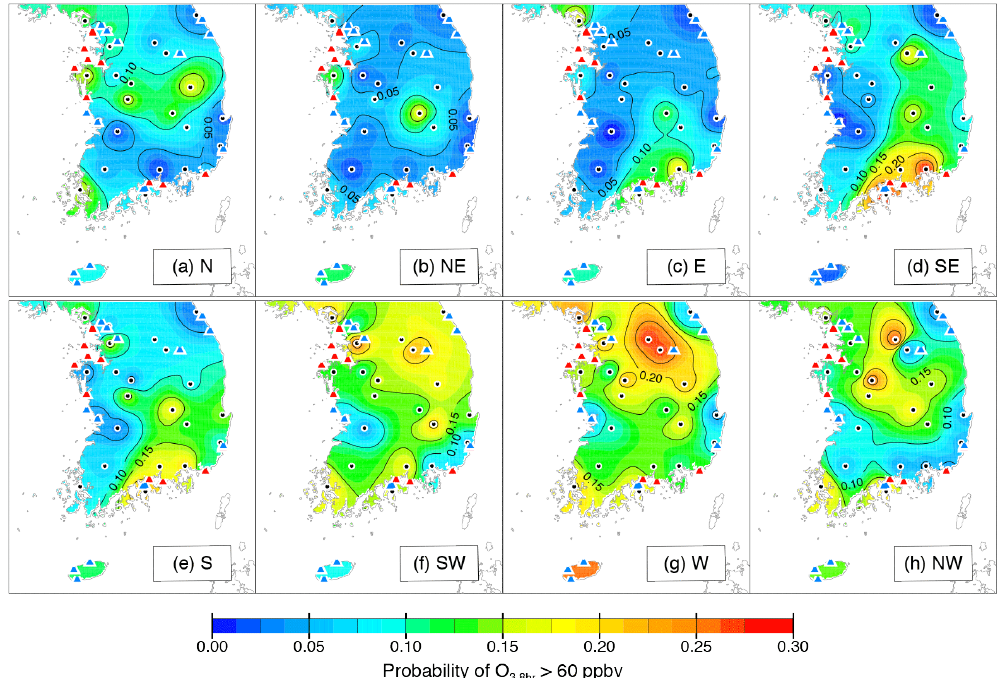
Figure 12. Spatial distributions of probabilities that the daily maximum 8h average O 3 (O 38h ) will exceed the air quality standard of South Korea (60ppbv) for each WD: (a) N, (b) NE, (c) E, (d) SE, (e) S, (f) SW, (g) W, and (h) NW, respectively. Black dots denote 25 weather stations of KMA and triangles denote 26 major thermoelectric power plants in South Korea (blue triangle <1000MW, red triangles ≥